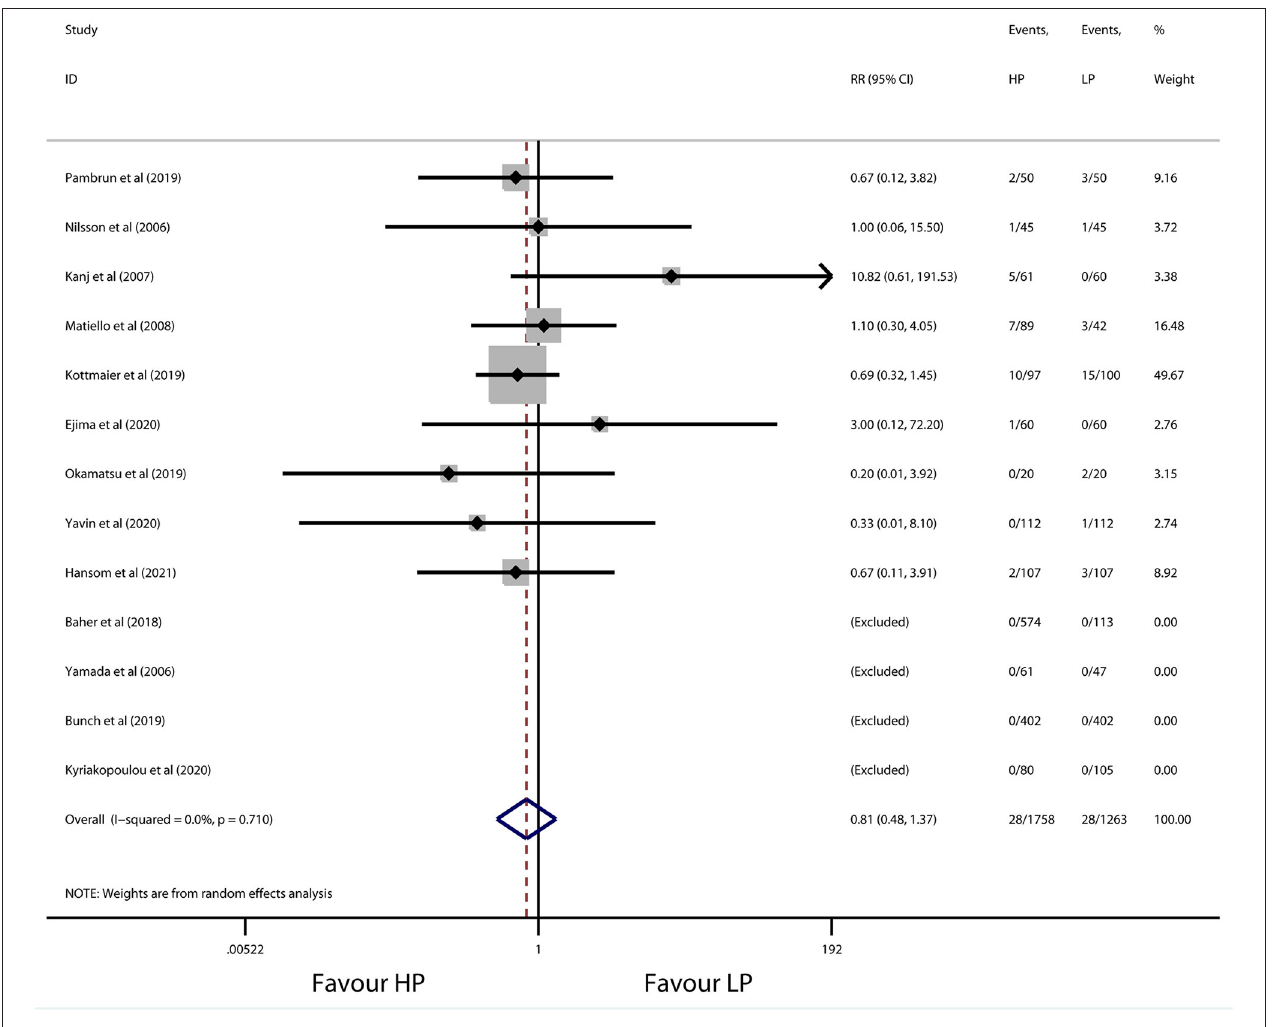
FIGURE 6 | Forest plot of procedure-related complications for high-power ablation vs. conventional-power ablation.